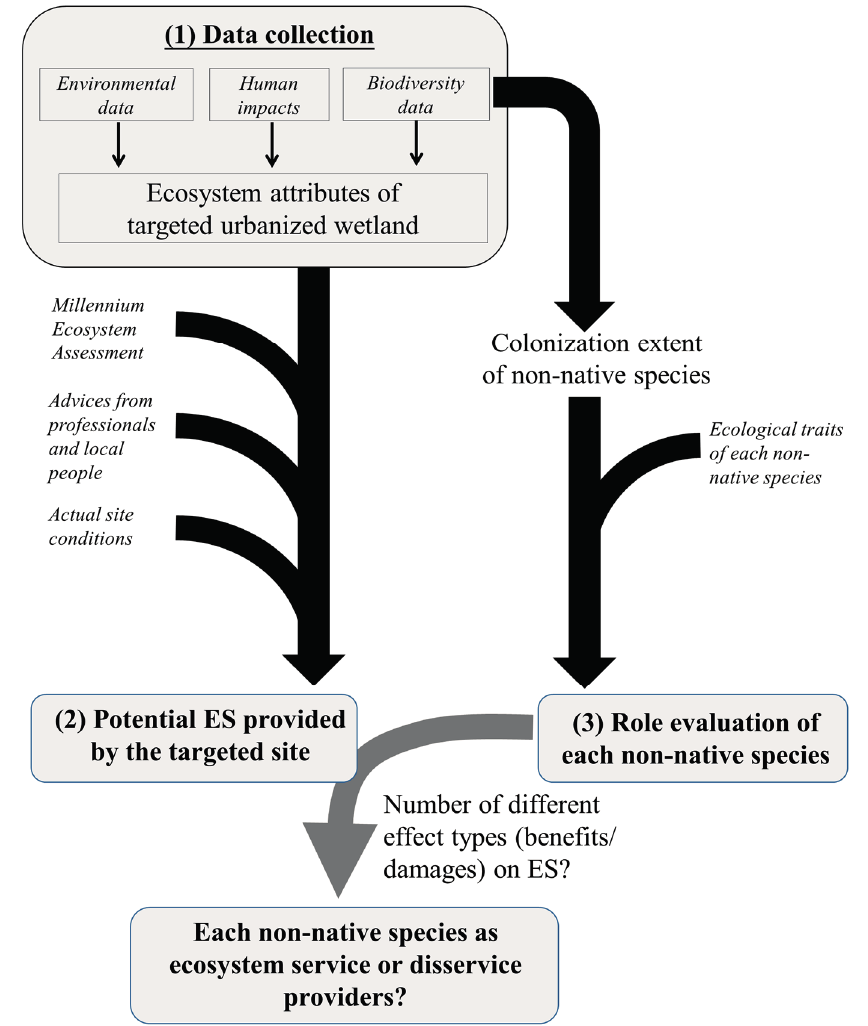
Figure 3. Conceptual framework for evaluating the role of non-native species in urbanized wetlands based on ES